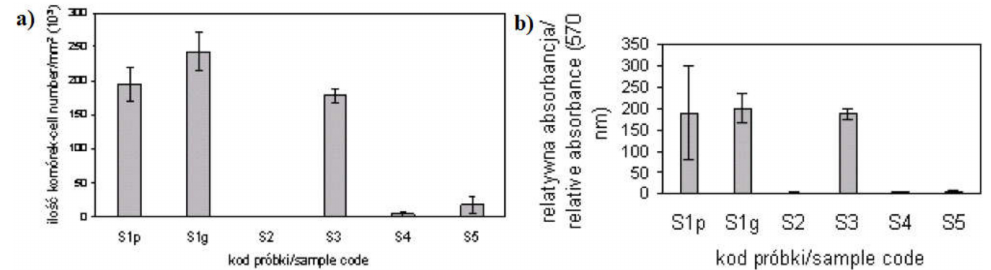
Figure 5. ( a ) Amount of S. epidermidis cells on modified titanium alloy surfaces. ( b ) S. epidermidis biofilm formation on Ti alloy surfaces. Biofilm formation was presented as a function of extracted crystal violet absorbance (570 nm) per mm 2 ; value for non-modified titanium alloy S1p was taken as 100%. Reproduced with permission from Belcarz, A.; Bienia´s, J.; Surowska, B.; Ginalska, G., Eng. Biomater. 2009